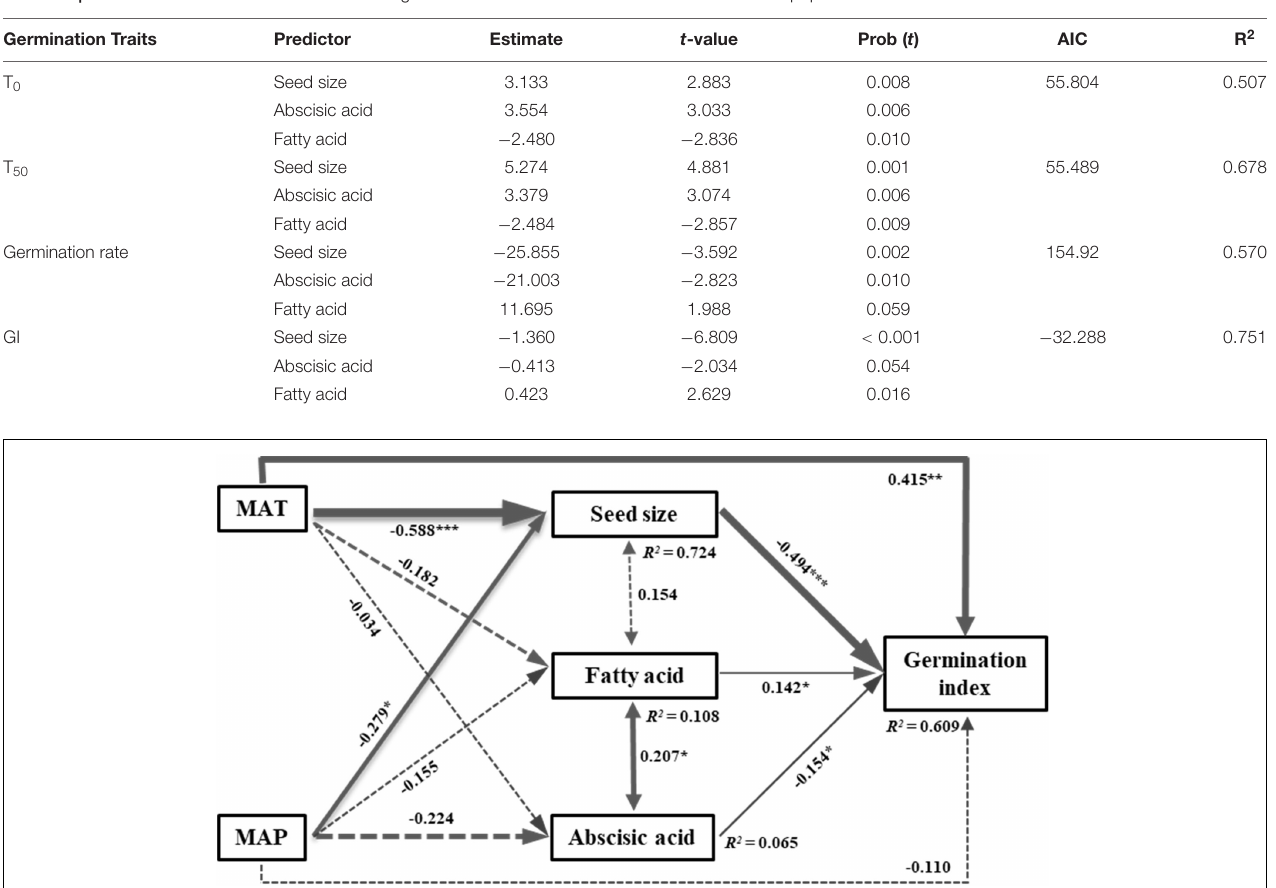
FIGURE 4 | Structural equation model of the direct and indirect effects of climatic variables on seed germination index. Chi-squared = 3.307, df = 1, P = 0.069, CFI = 0.992. Numbers adjacent to the pathway are standardized path coefficients (* P < 0.05, ** P < 0.01, and *** P < 0.001). Arrow widths are proportional to the standardized path coefficients. Portion of the variance explained by the model are indicated by R 2 values. The solid and dash lines represent significant and non-significant effects, respectively. MAT, mean annual temperature; MAP, mean annual